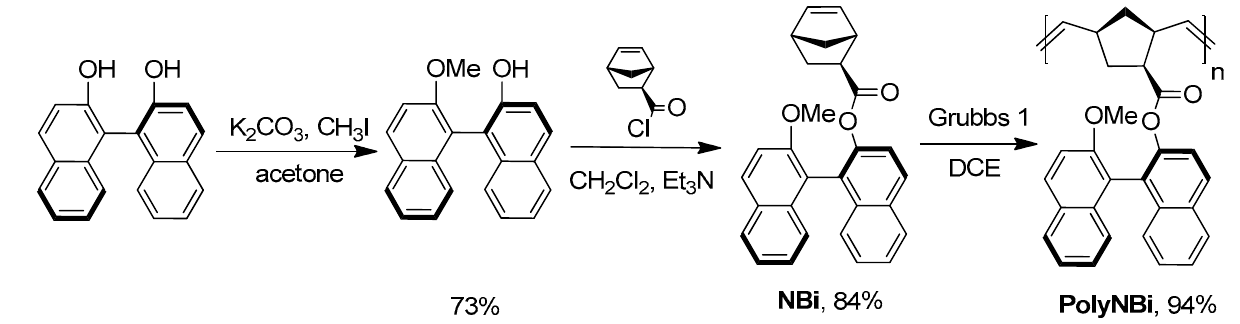
Figure 1. The synthesis and metathesis polymerization of the ester of exo -5-norbornenecarboxylic acid and 1,1 ′ -bi-2-naphthol.